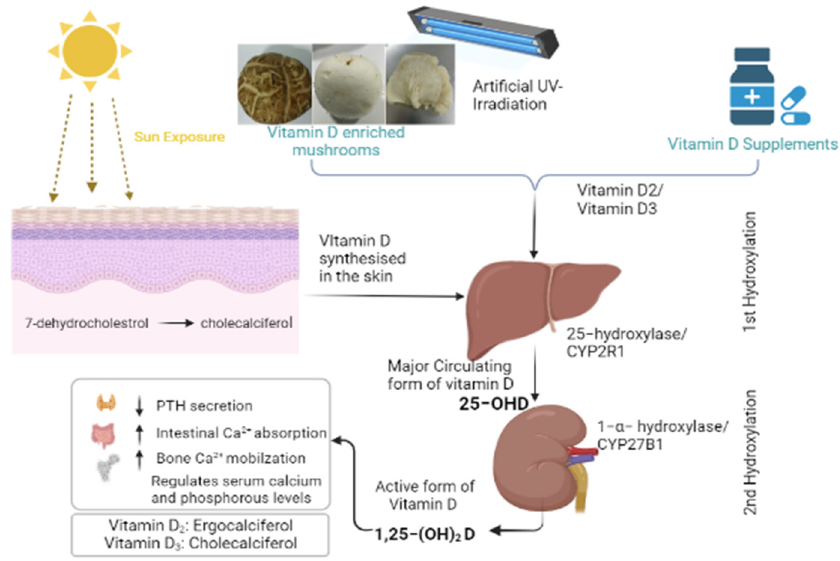
Figure 1. Metabolism of vitamin D in the body.